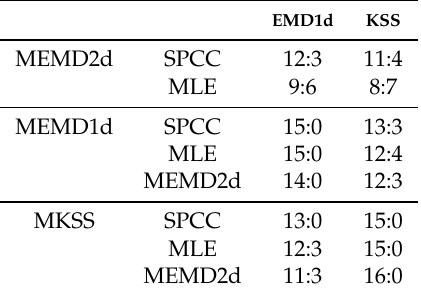
Table 4. Performance